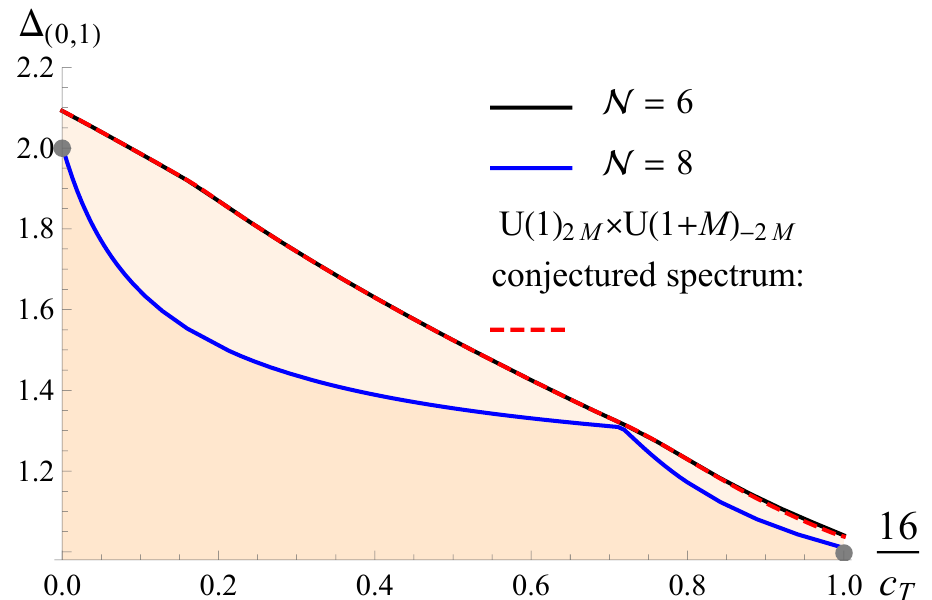
Figure 3 . Upper bounds on the scaling dimension of the lowest dimension ‘ = 0 long multiplet in terms of c T for the Long [000] , 1 superconformal structure, which for parity preserving theories has ∆ , 0 the same parity as the superprimary. The orange shaded region is allowed, and the plot ranges from the GFFT limit c T → ∞ to the free theory c T = 16 . The black line denotes the N = 6 upper bound computed in this work with Λ = 39 , the blue line denotes the N = 8 upper bound computed in [10] with Λ = 43 . The red dashed line denotes the spectrum read off from the functional saturating the lower bound in figure 1, which we identify with the U(1) 2 M × U(1 + M ) − 2 M theory. The gray dots denote the GFFT and free theory values from table